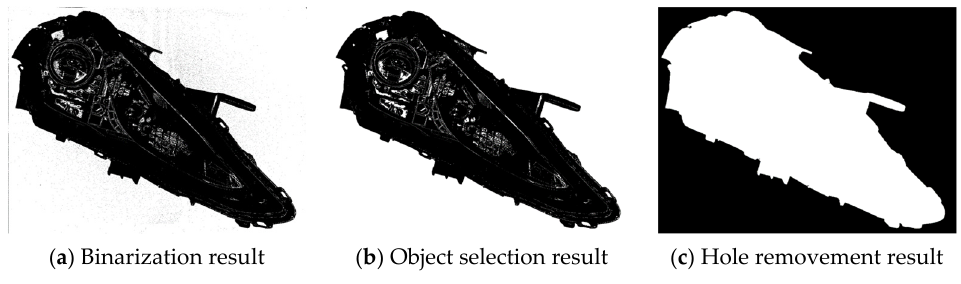
Figure 6. Object detection.